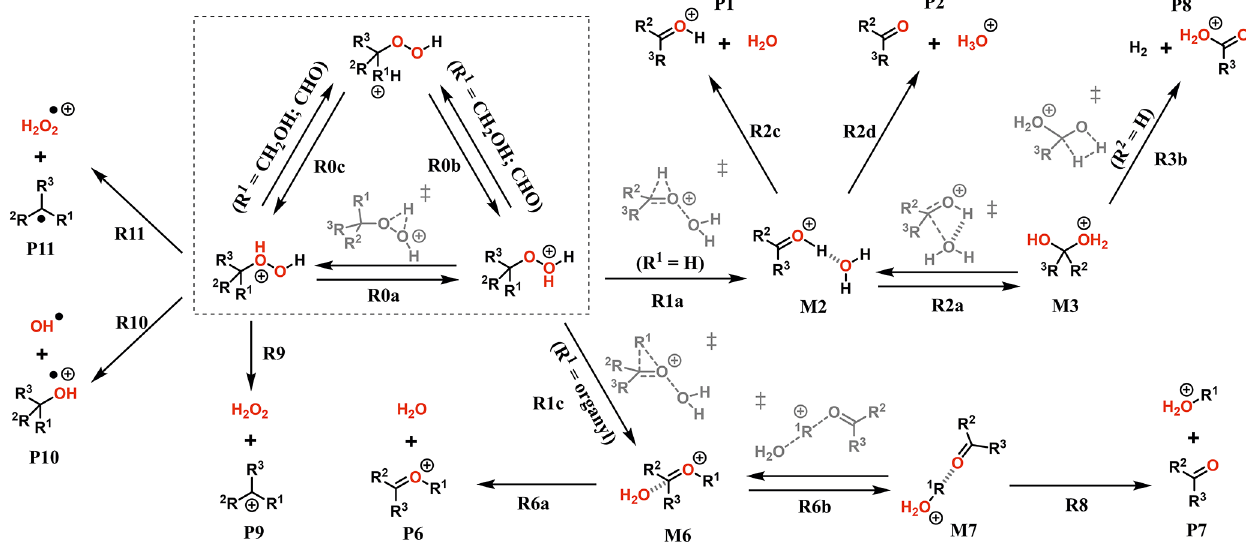
Figure 8. General mechanism for the decomposition of ROOH following protonation. Species within the dashed box are the initial pro- tonation isomers. Transition states are shown in gray. Some pathways are not available for every ROOH investigated. Compound-specific pathways with yields less than 0.1% are omitted for